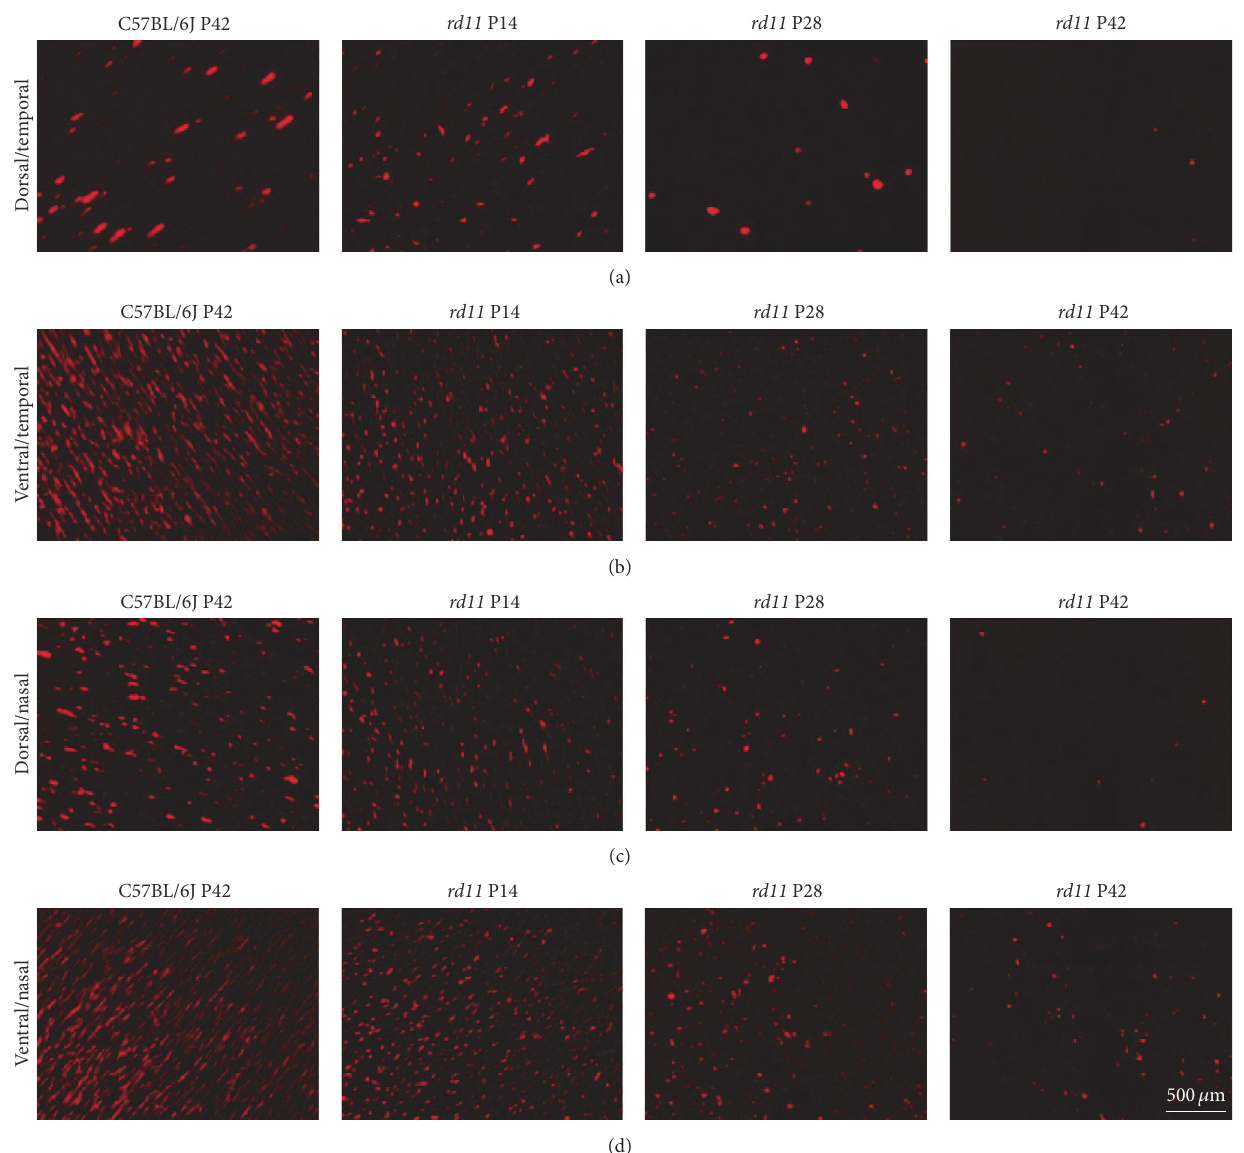
Figure 3: Immunofluorescence staining of S-opsin in retinal whole mounts (Cy3 × 400). (a)–(d) Representative S-opsin staining in the dorsal/temporal (a), ventral/temporal (b), dorsal/nasal (c), and ventral/nasal (d) quadrants of the retina from P42 C57BL/6J control and P14, P28, and P42 rd11 mice. 𝑛 = 5 retina per group.